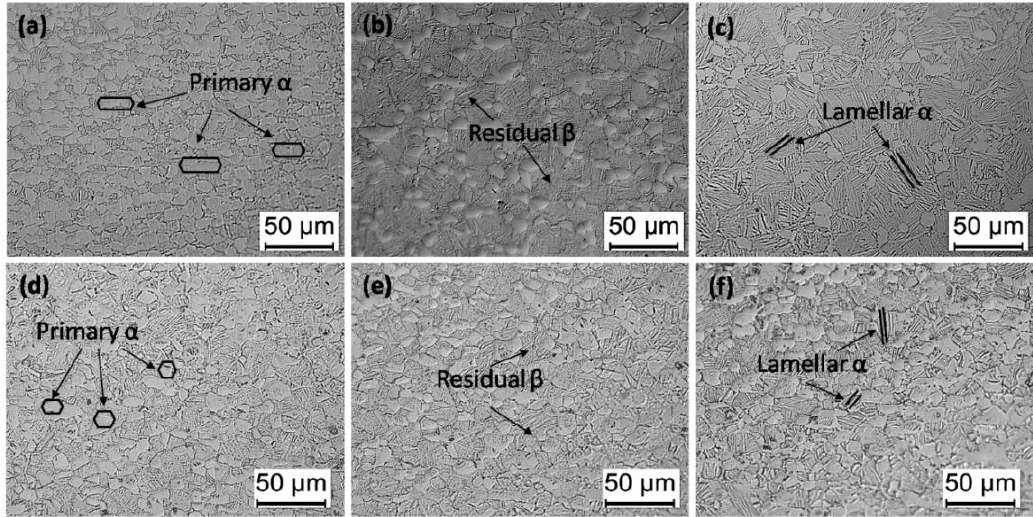
Figure 3. Microstructure of Ti6Al4V alloy treated by: ( a ) 920 °C × 1 h, AC, ( b ) 960 °C × 1 h, AC, and ( c ) 980 °C × 1 h, AC, ( d ) 960 °C × 1 h, AC + 600 °C × 2 h, AC, ( e ) 960 °C × 1 h, AC + 650 °C × 2 h, AC, ( f ) 960 °C × 1 h, AC + 700 °C × 2 h, AC.